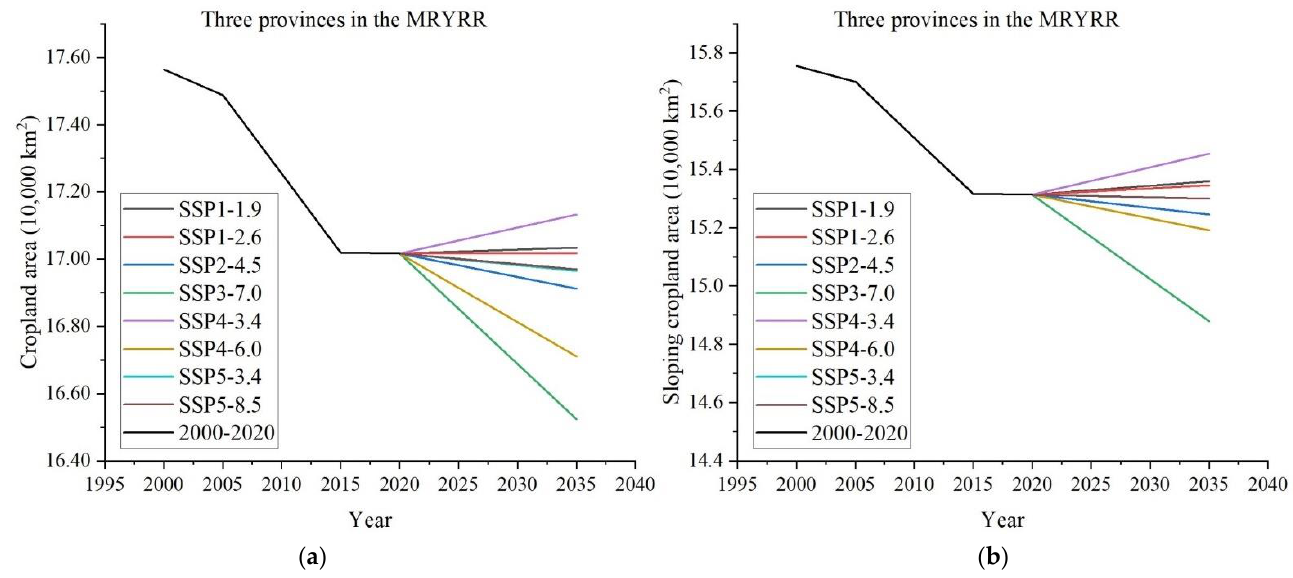
Figure 5. Predicted change trends in cropland and sloping cropland under different scenarios. ( a ) Predicted cropland areas in 2035. ( b ) Predicted sloping cropland areas in 2035.